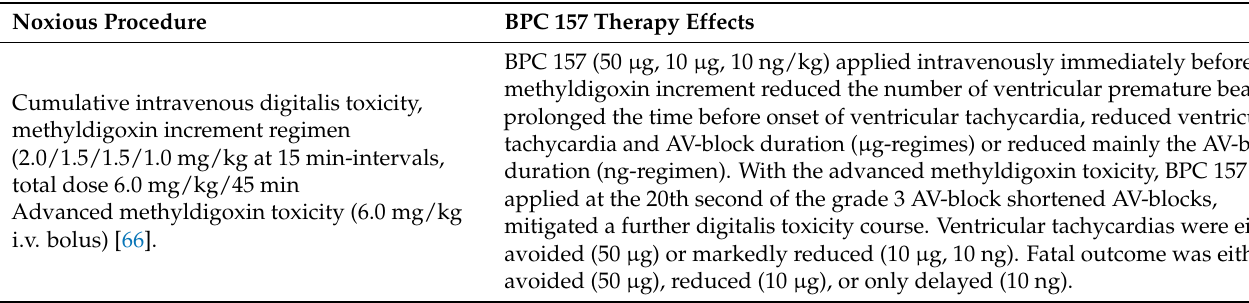
Table 3. Summarized presentation of the BPC 157 therapy effect on arrhythmias [66–72]. Note,